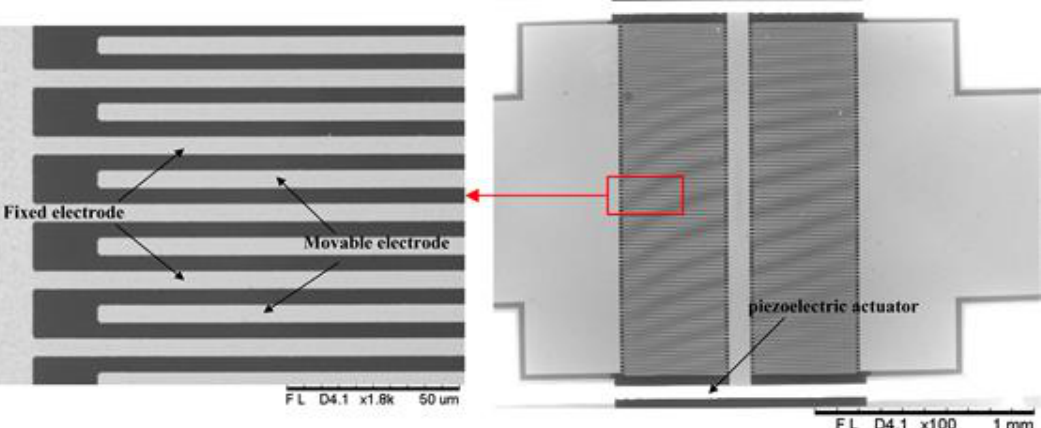
Figure 11. Scanning electron micrograph (SEM) photos of the microsensor chip. The widths of the fixed and movable electrodes are both 5 μm; the gap between the fixed and movable electrodes is 5 μm.